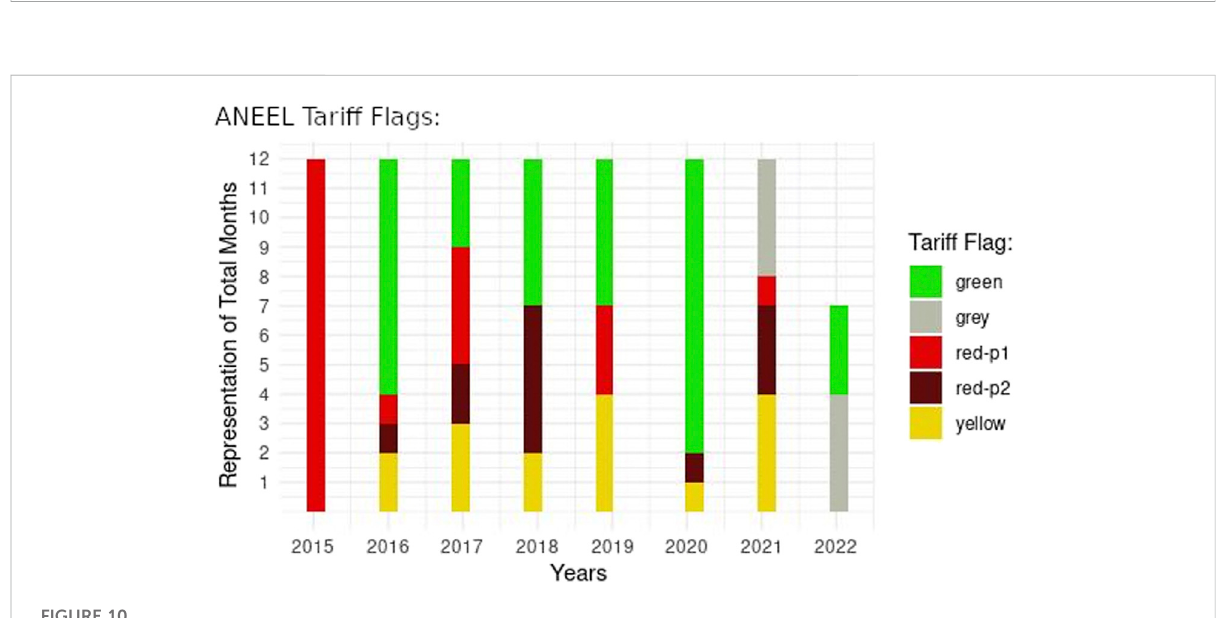
FIGURE 9 Summary of the production of global indicators by objective (%) [29].